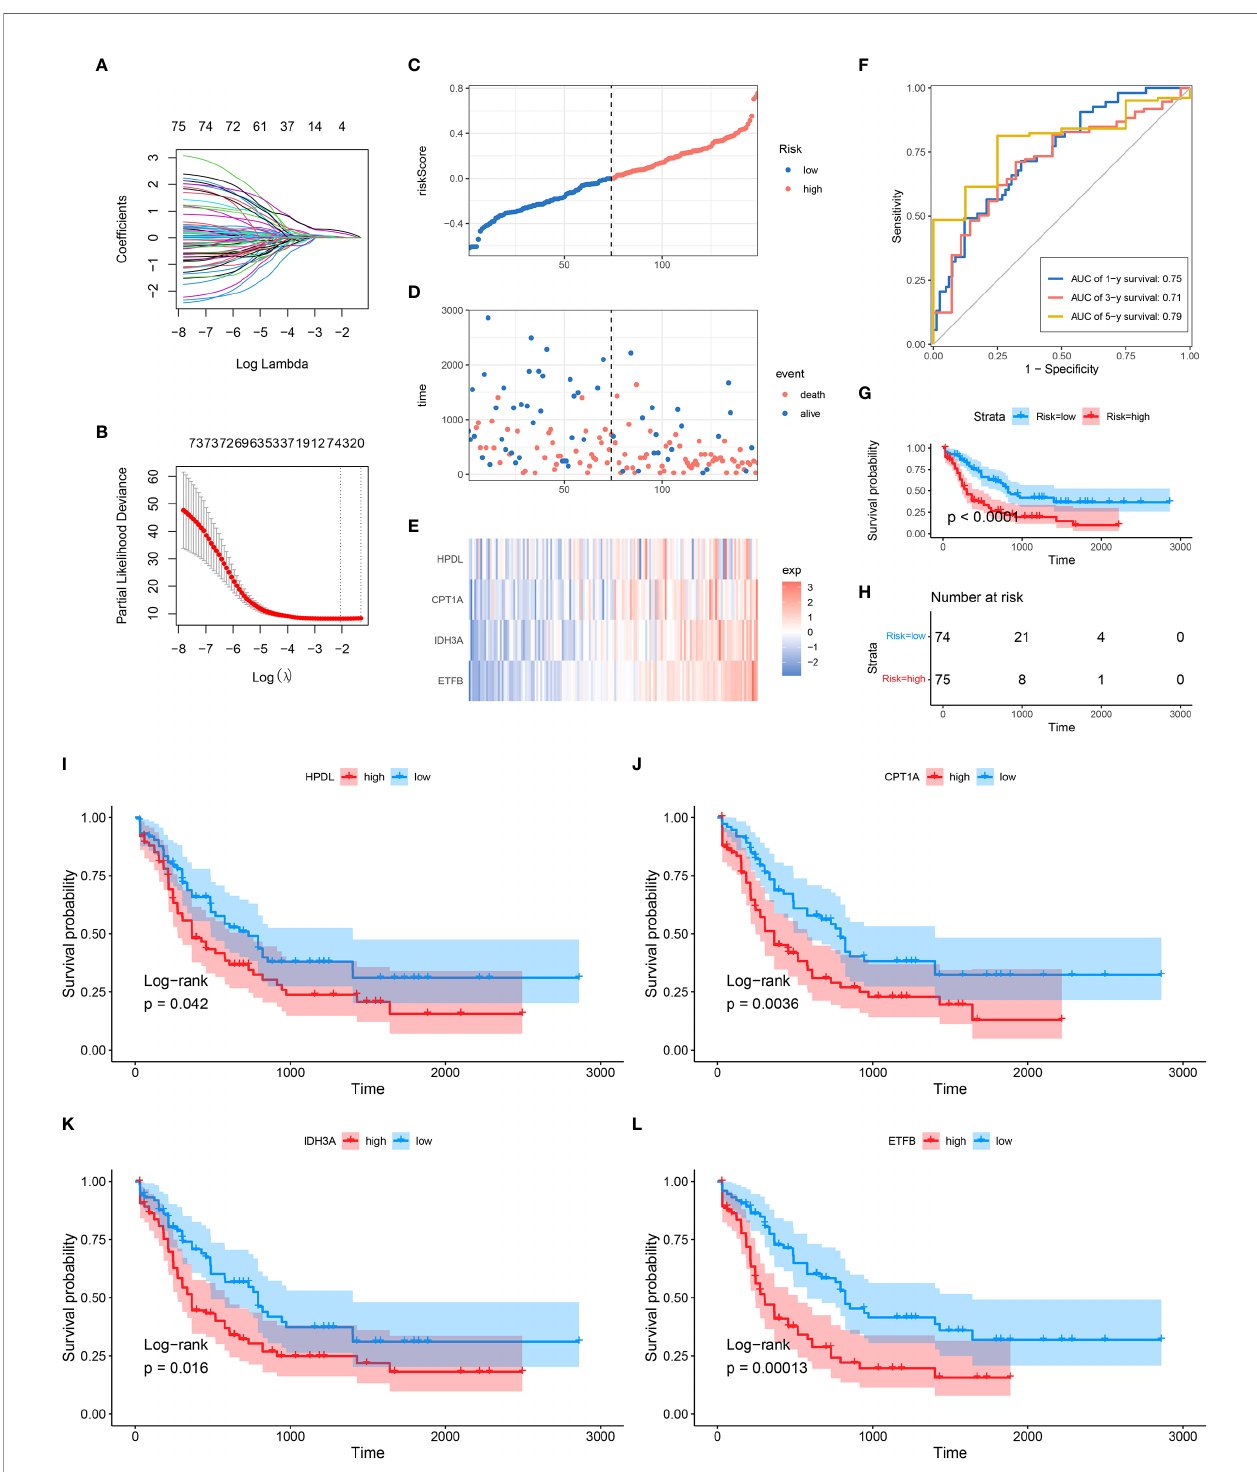
FIGURE 2 | Construction of MRG-based prognostic classi fi er. (A) Each gene ’ s trajectory. The horizontal axis represents the log value of the gene lambda, and the vertical axis represents the independent gene ’ s coef fi cient. (B) CIs with different values of lambda, (C – E) Distribution of risk score, survival status, and expression of 4 MRGs in TCGA-AML cohort. (F) ROC curve of 4 MRGs ’ signature prediction. (G, H) KM survival curves between two risk groups based on 8-gene signature classi fi cation. (I – L) The KM survival plots of 4 MRGs. MRG, mitochondria-related gene; ROC, receiver operating characteristic; KM, Kaplan –